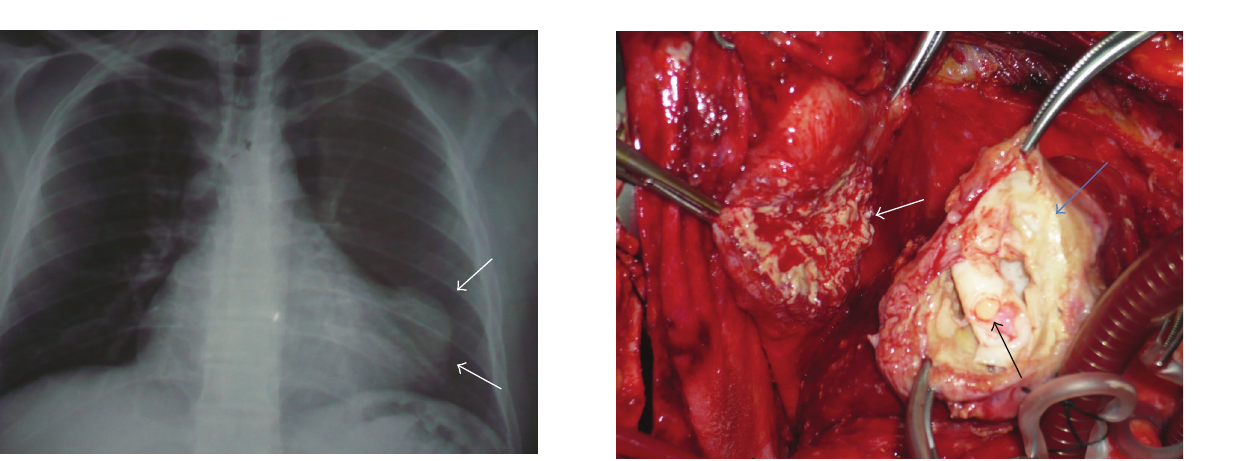
Figure 4: Image of cardiac cyst after dissection from adherent pericardium and opening of gauze pads with povidone-iodine. Pericardium, myocardium, cuticular membran, germinative, (blue arrow) membrane and daughter vesicles, (black